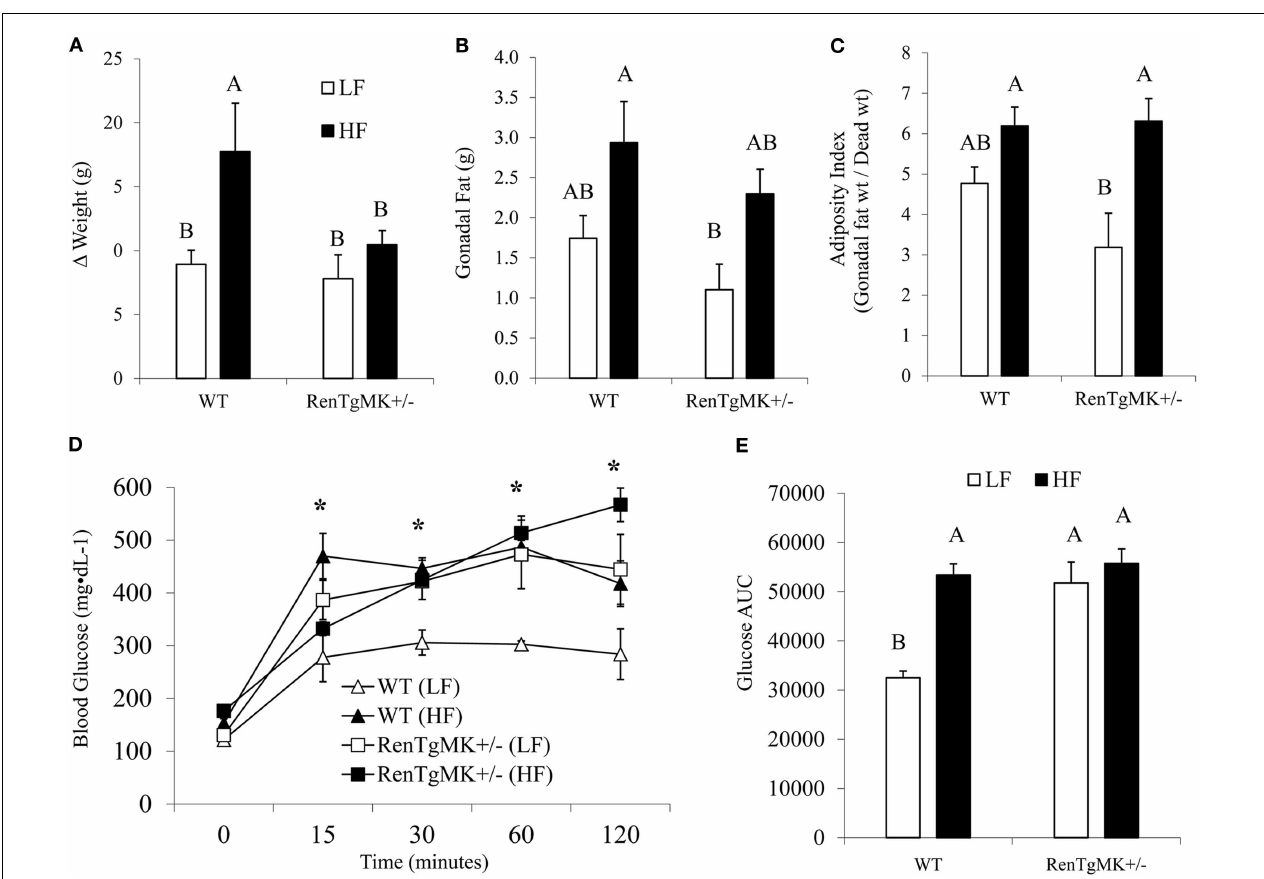
pad weight by final body weight X 100. (D) A glucose tolerance test (GTT) was administered after overnight fasting. Blood glucose levels were measured at 0, 15, 30, 90, and 120min and plotted on a graph. (E) Area Under the Curve (AUC) was calculated as described in the experimental procedures.Values are means ± SE. n = 3 For each group. *Significantly different ( P < 0.05) from WT-LF. Different letters indicate a significant difference ( P <